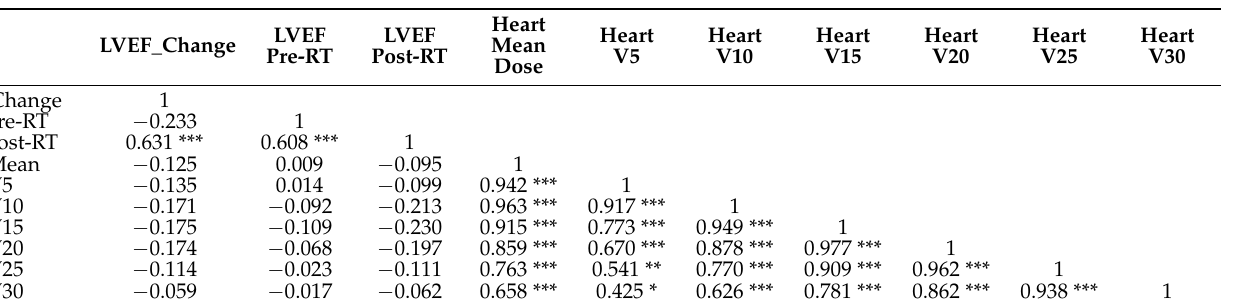
Figure 2. The assessment of LVEF before and after RT for the 30 eligible left-breast cancer patients who received RNI with VMAT or HT. The linear function is included. Abbreviations: LVEF—left ventricular ejection fraction; RT—radiation therapy; RNI—regional nodal irradiation; VMAT—volumetric-modulated arc therapy; HT—helical tomotherapy. Table 3. Associations between cardiac dose (heart mean dose, V5–V30) and LVEF (pre-/post-RT, change in values) in the 30 eligible left-breast cancer patients. The coefficient values were calculated using the Pearson correlation coefficient method.